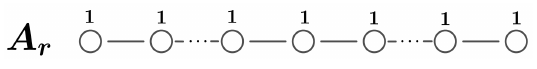
Figure 5 . Dual Coxeter labels for the A